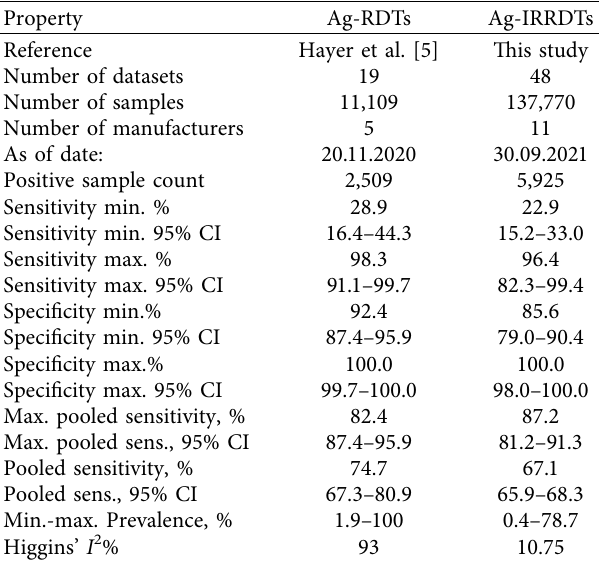
Figure 5: Forest diagrams for 5 different brands of Ag-IRRDTs. With the pooled diagnostic odds ratio DOR [322.423–386.688] and tests for equality of sensitivities and for specificities all show that heterogeneity of datasets for major Ag-IRRDT manufacturers is high. Although Shenzen Bioeasy FIA demonstrated the highest sensitivity value over 87%, the number of studies using this test and their pooled sample size (3, 410) were low. Note that its 95% CIs have the widest ranges for both sensitivity and specificity parameters. LumiraDX demonstrated a sensitivity of 81.8% with larger number of studies and samples (10 and 4,697, respectively) with relatively narrow ranges of CIs. Surveillance studies were included in Quidel Sofia and SD Biosensor Standard F Quidel Sofia showed highest specificity value. (Values are displayed in two-digit Table 3: Comparison of two systematic review studies. Our study presenting only instrument-read rapid antigen tests is compared and contrasted with another review 4 that included only rapid antigen tests which does not employ any reader equipment. Pos- itive sample counts are those tests that were confirmed by qRT- PCR.